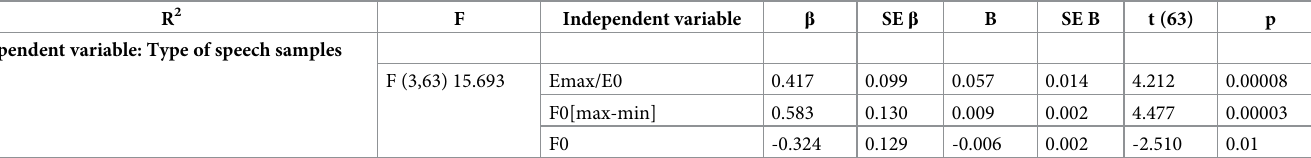
Table 3. The correlation between acoustic features of speech and types of emotional acting speech of Russian children (Multiple Regression analysis data). R 2